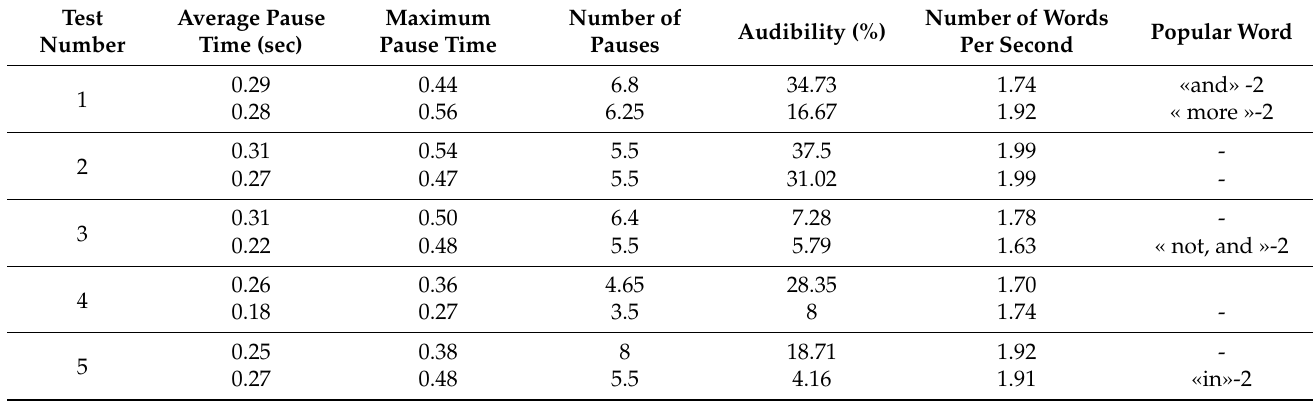
Table 2. Average indicators of user